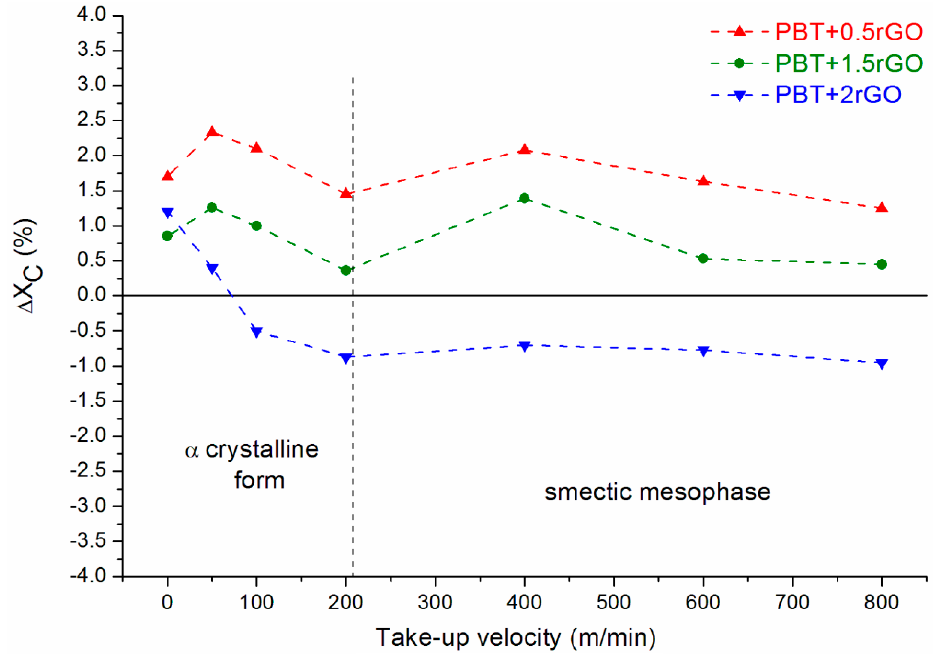
Figure 8. The dependence of the difference in the degree of crystallinity ( Δ X C ) of fibers containing rGO and pure PBT fibers on the take-up velocity.